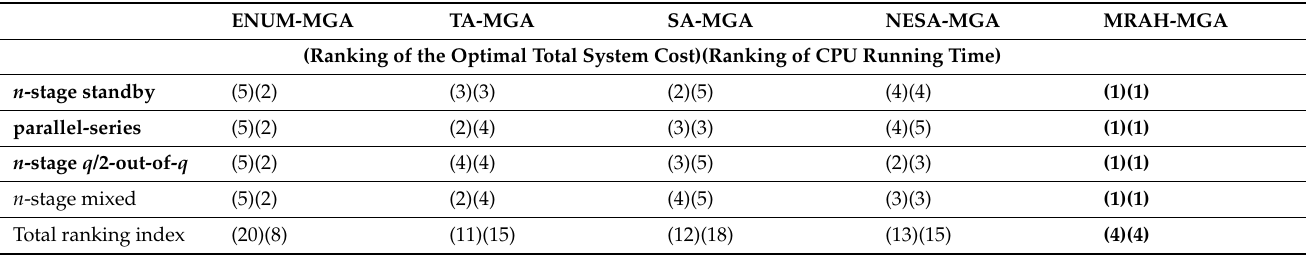
Table 46. The performance ranking of the optimal total system cost and CPU running time for five combined methods based on four system configurations.